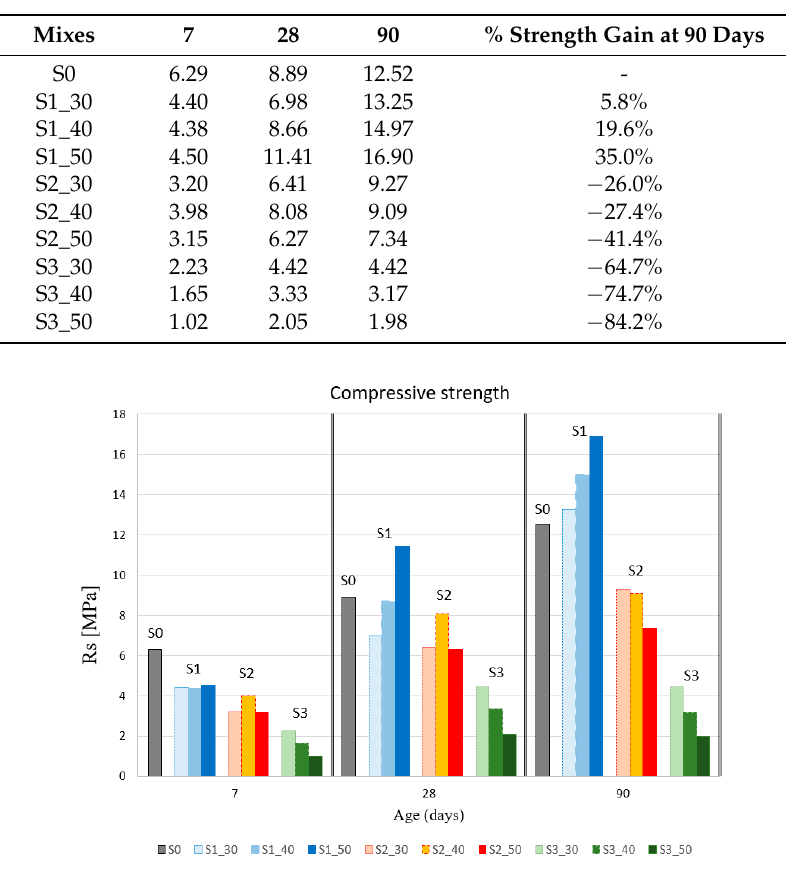
Figure 5. Flexural strength evolution (MR/MR S0 ).